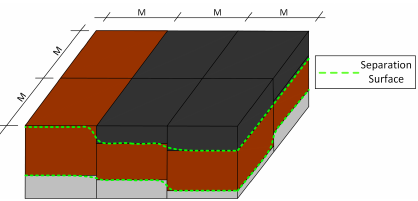
Figure 8. Separation surface between layers of